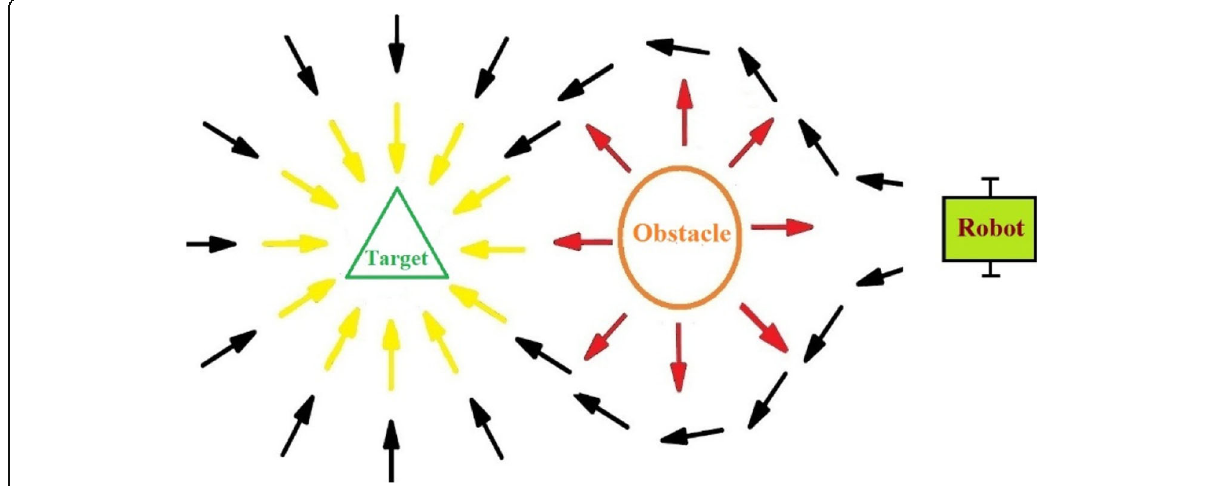
Fig. 5 Artificial potential field model